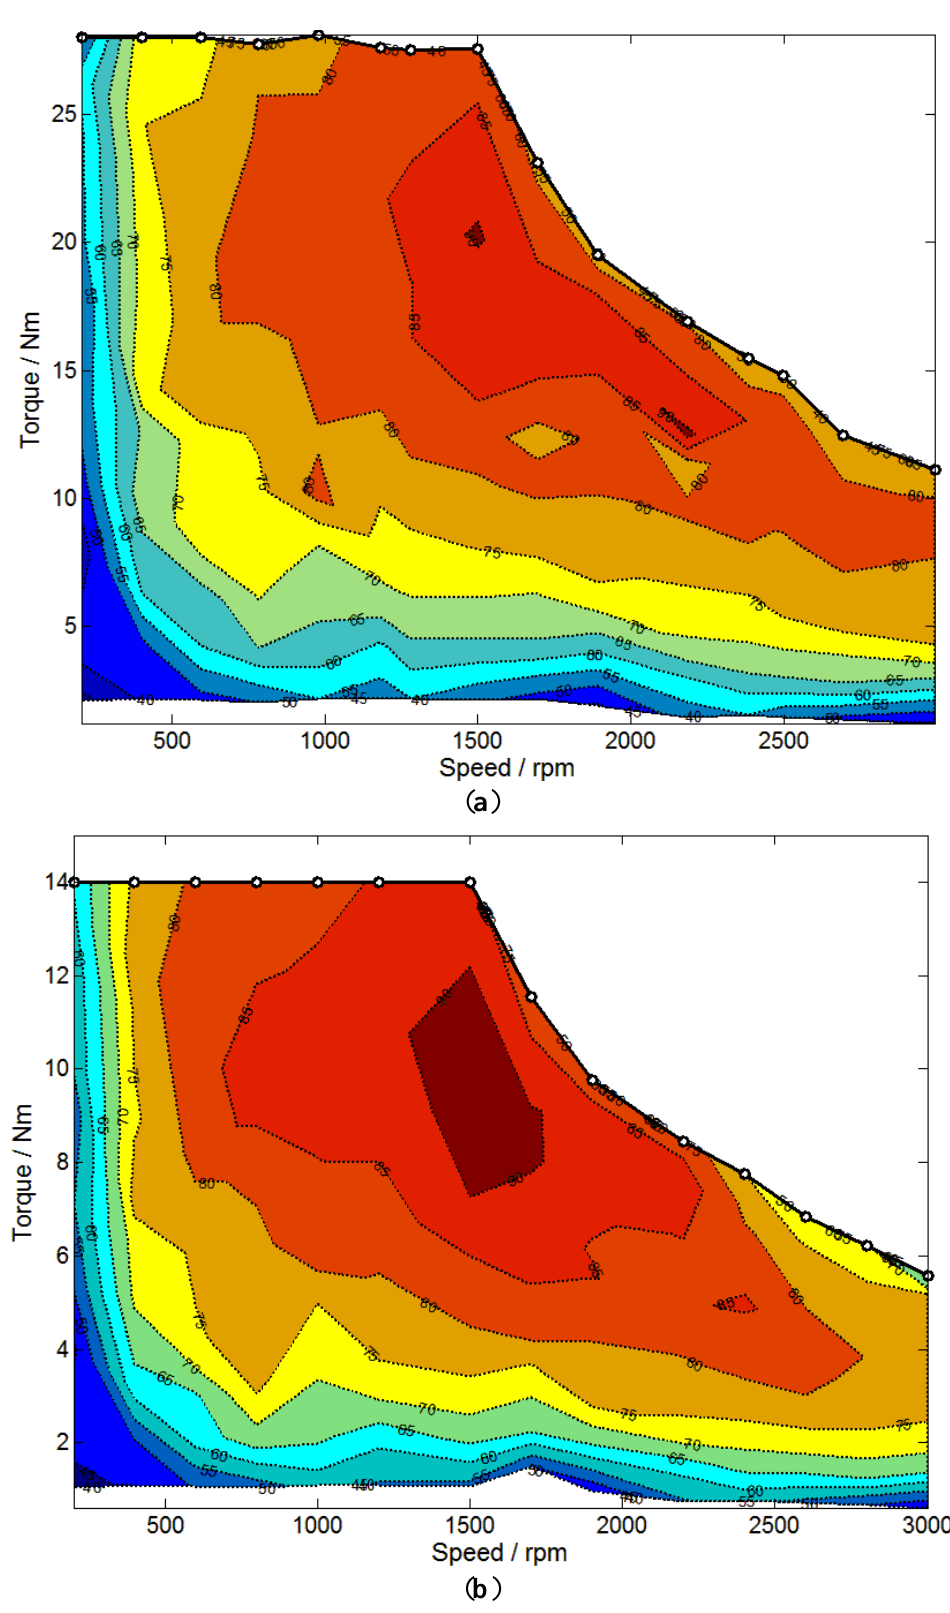
Figure 30. Test efficiency Map of SRDRM: ( a ) The efficiency Map of outer motor; ( b ) The efficiency Map of inner